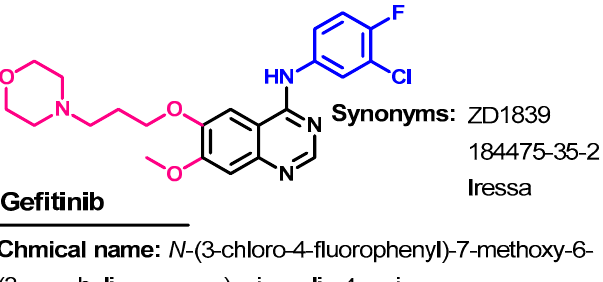
Figure 30. Chemical structure/name/synonyms of afatinib.